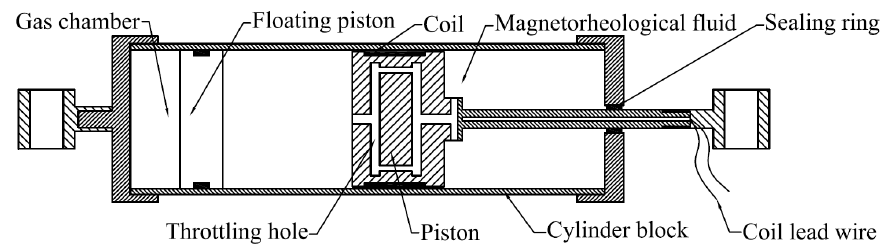
Figure 2. The structure of magnetorheological damper